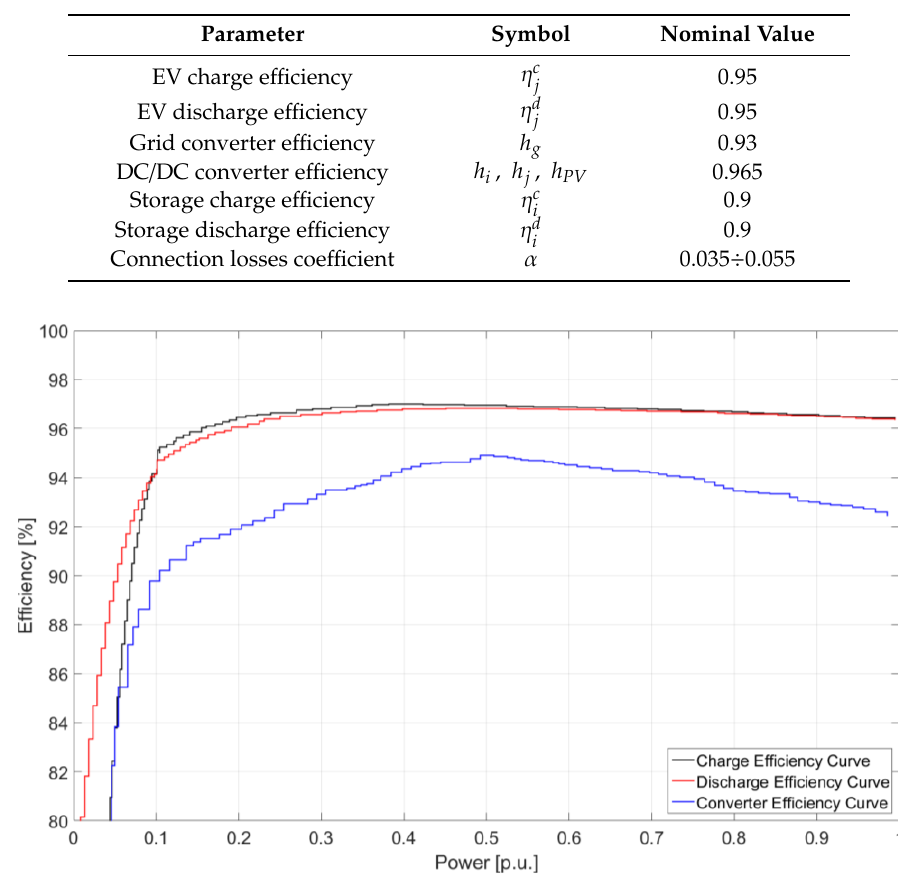
Figure 4. Converter efficiency curves.